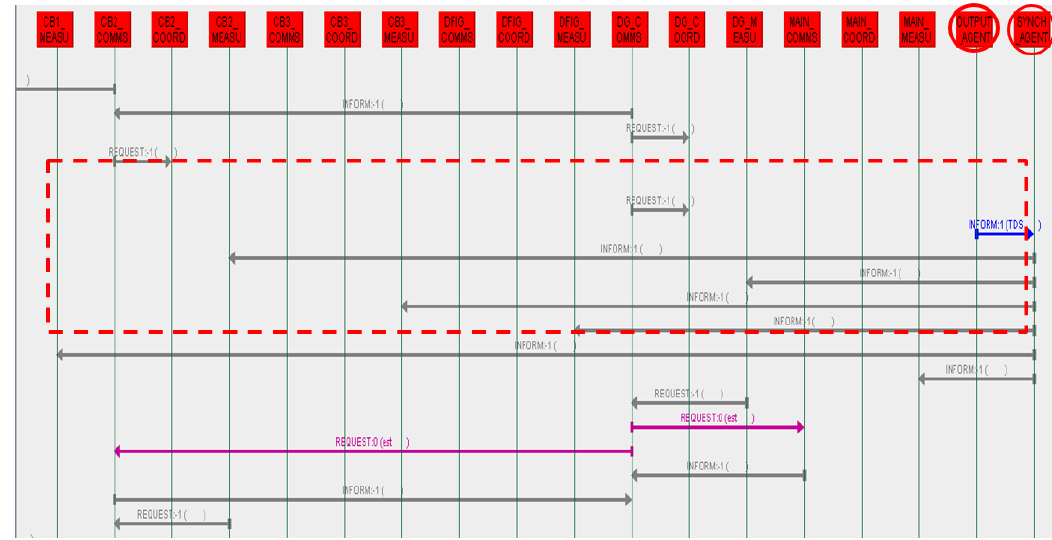
Figure 19. Messaging coordination to synchronize real-time interactions between the agent layer and the power system.